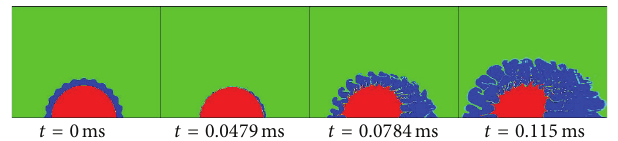
Figure 6: Evolution of a droplet with an unstable vapor film ( 𝜌 𝑑 = 7000 kg/m 3